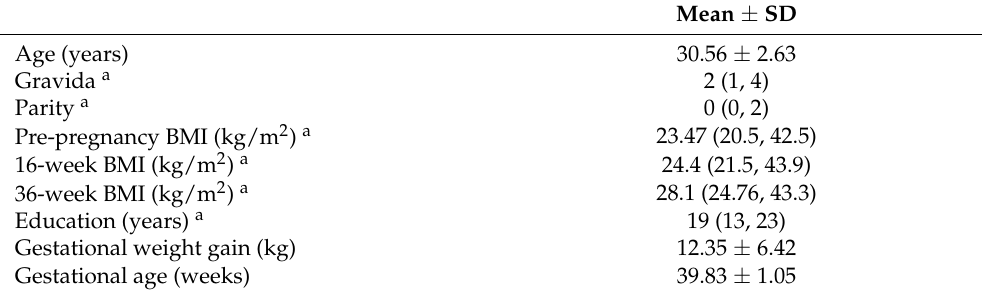
Table 1. Maternal descriptors.